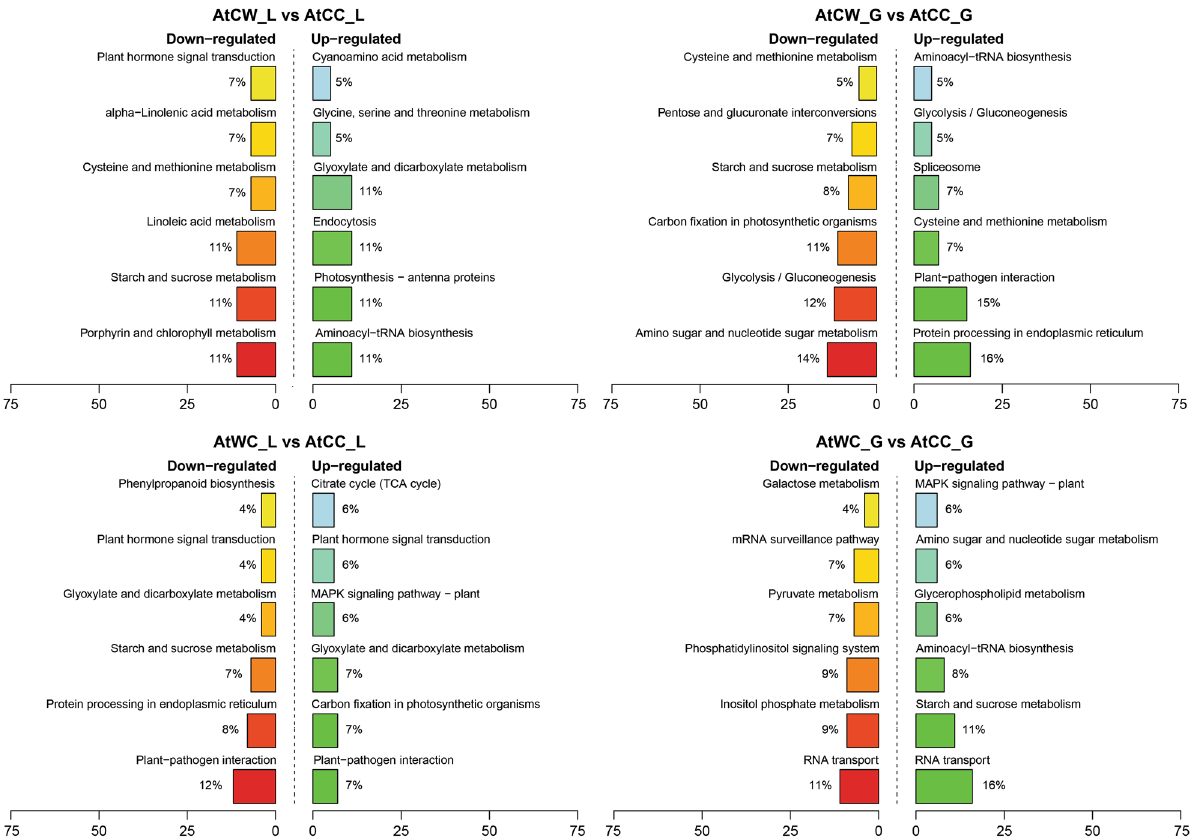
Figure 3. KEGG pathway classification of stress-responsive miRNA-miRNA regulatory modules. Down- regulated, mRNA targets were less abundant in the water-deficit stress treated progeny. Up-regulated, mRNA targets were more abundant in the water-deficit stress treated progeny. The treatment groups are: AtCC (DBA Artemis control group parents, progeny treated with control), AtCW (DBA Artemis control group parents, progeny treated with water-deficit stress), AtWC (DBA Artemis water-deficit stress group parents, progeny treated with control), AtWW (DBA Artemis water-deficit stress group parents, progeny treated with water- deficit stress). _L represents flag leaf libraries, _G represents developing grain